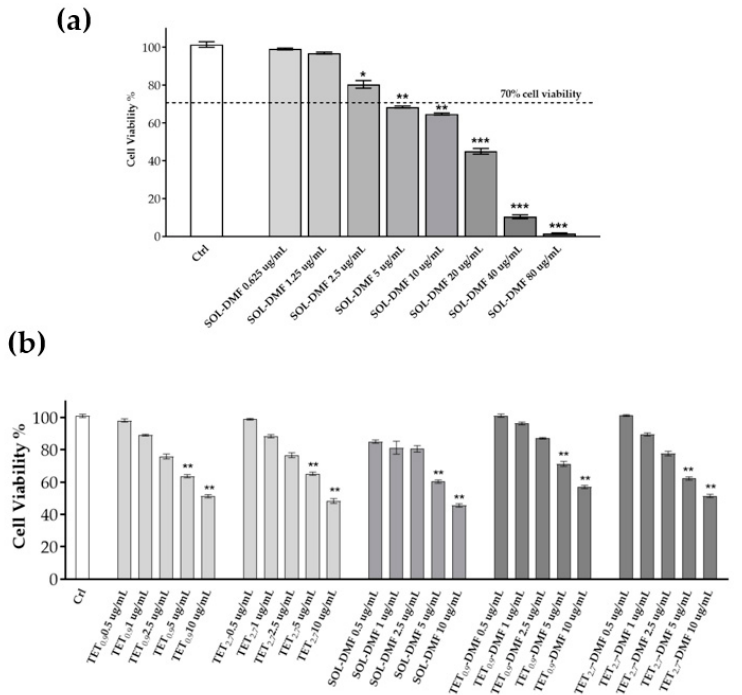
Figure 5. HaCaT cell viability evaluated using an MTT test after 24 h of treatment with SOL-DMF differently diluted (from 0.625 µg/mL to 80 µg/mL) ( a ) and with differently diluted DMF-loaded or